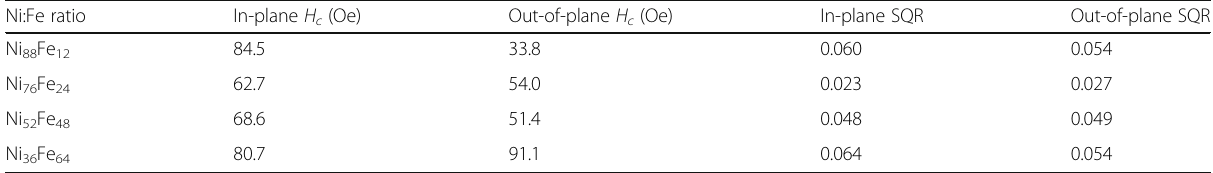
Table 1 Coercivity H c and squareness SQR = M r / M s values of NiFe MNPs for Ni 88 Fe 12 , Ni 76 Fe 24 , Ni 52 Fe 48 , and Ni 36 Fe 64 Ni:Fe ratio In-plane H c (Oe) Out-of-plane H c (Oe) In-plane SQR Out-of-plane SQR Ni 88 Fe 12 84.5 33.8 0.060 0.054 Ni 76 Fe 24 62.7 54.0 Ni 52 Fe 48 68.6 51.4 80.7